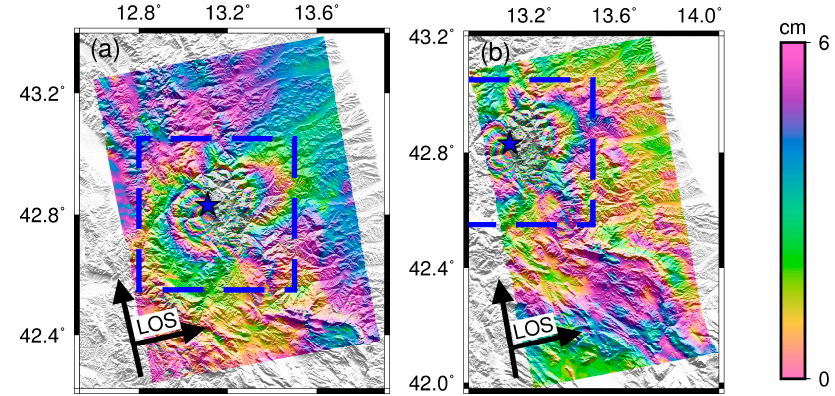
Figure 6. Coseismic interferograms of 30 October 2016 earthquake obtained from the ascending Sentinel-1 track T044 ( a ), the ascending ALOS-2 track P196A ( b ). The blue star corresponds to the epicenter of 30 October 2016 Norcia earthquake [12]. The interferograms are rewrapped with an interval of 6 cm. The blue rectangle outlines the study area.